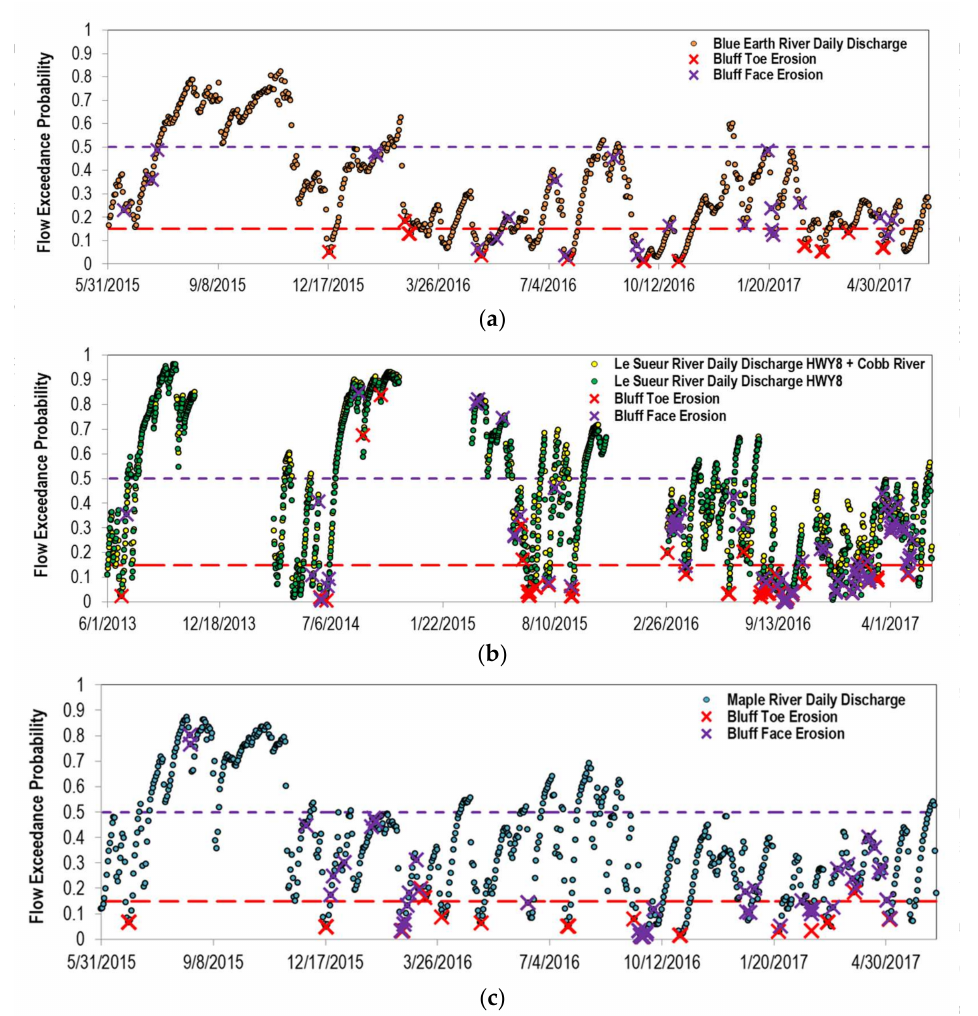
Figure A4. Daily river discharge plotted as flow exceedance probability (2007–2017 gage record) with the timing of toe and face bluff failures marked by red and purple X’s respectively. Dashed purple line indicates 50% flow exceedance probability, below which most face failures occur. Dashed red line indicates 20% flow exceedance probability, below which most toe failures occur for: (a) Blue Earth River sites (gages 05319500 and 05320000, USGS); (b) Le Sueur River sites (gages 32076001 and 32071001, MN DNR/MPCA Cooperative Stream Gaging); (c) Maple River sites (gage 32072001, MN DNR/MPCA Cooperative Stream